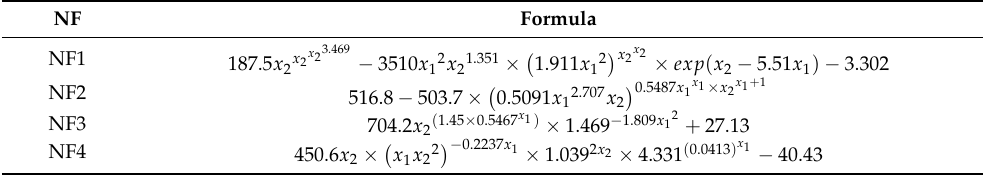
Table 4. The predicted formulas for the first four natural frequencies (NF) by MOGP algorithm. NF